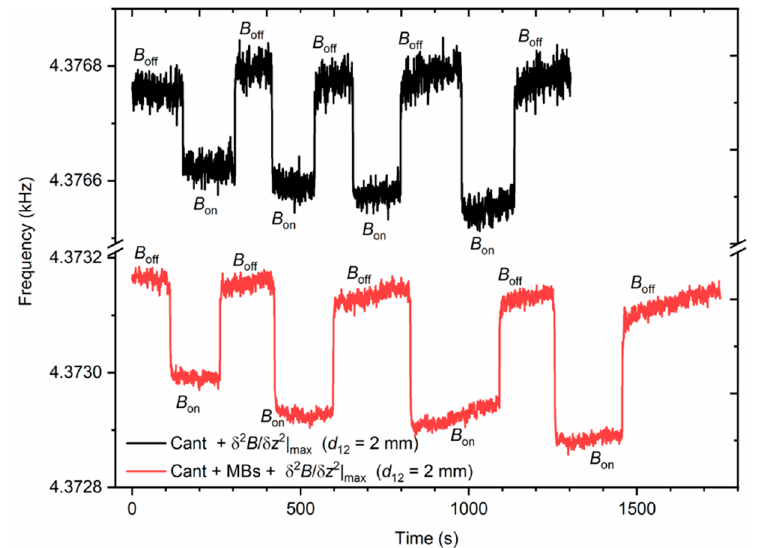
Figure 7. Frequency response of a bare (black line) and magnetic particle-laden (red line) cantilever (S80/CAN30-1-2) under an external magnetic force field gradient induced by a pair of NdFeB permanent magnets (2 mm apart). The observed frequencies were monitored over time under phase-locked loop (PLL) condition when the field was switched on ( B on ) and off ( B off ). The test sample consisted of 2 µm-sized magnetic polystyrene particles. The cantilever sensor was excited in an out-of-plane mode (along the z -axis) and the magnetizing field was induced parallel with the excitation direction.